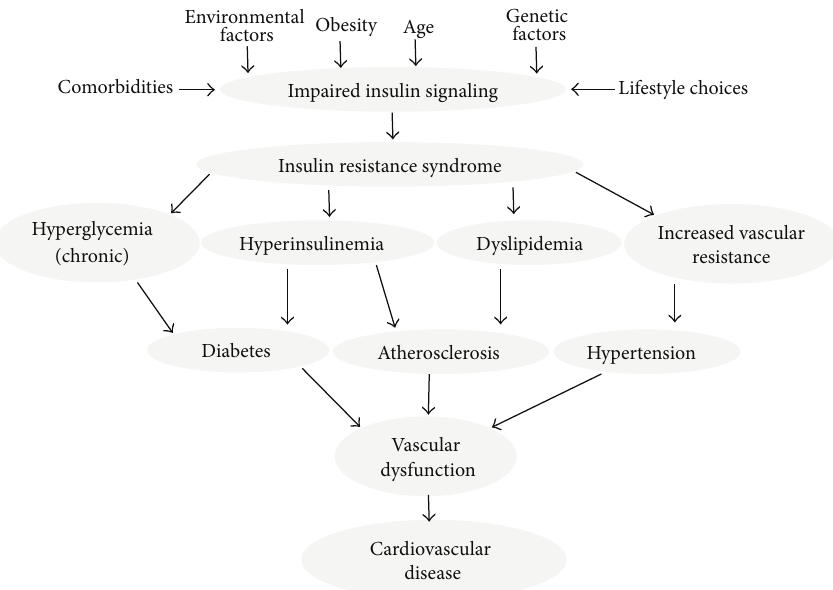
Figure 1: The contribution of impaired insulin signaling to vascular dysfunction and the development of cardiovascular